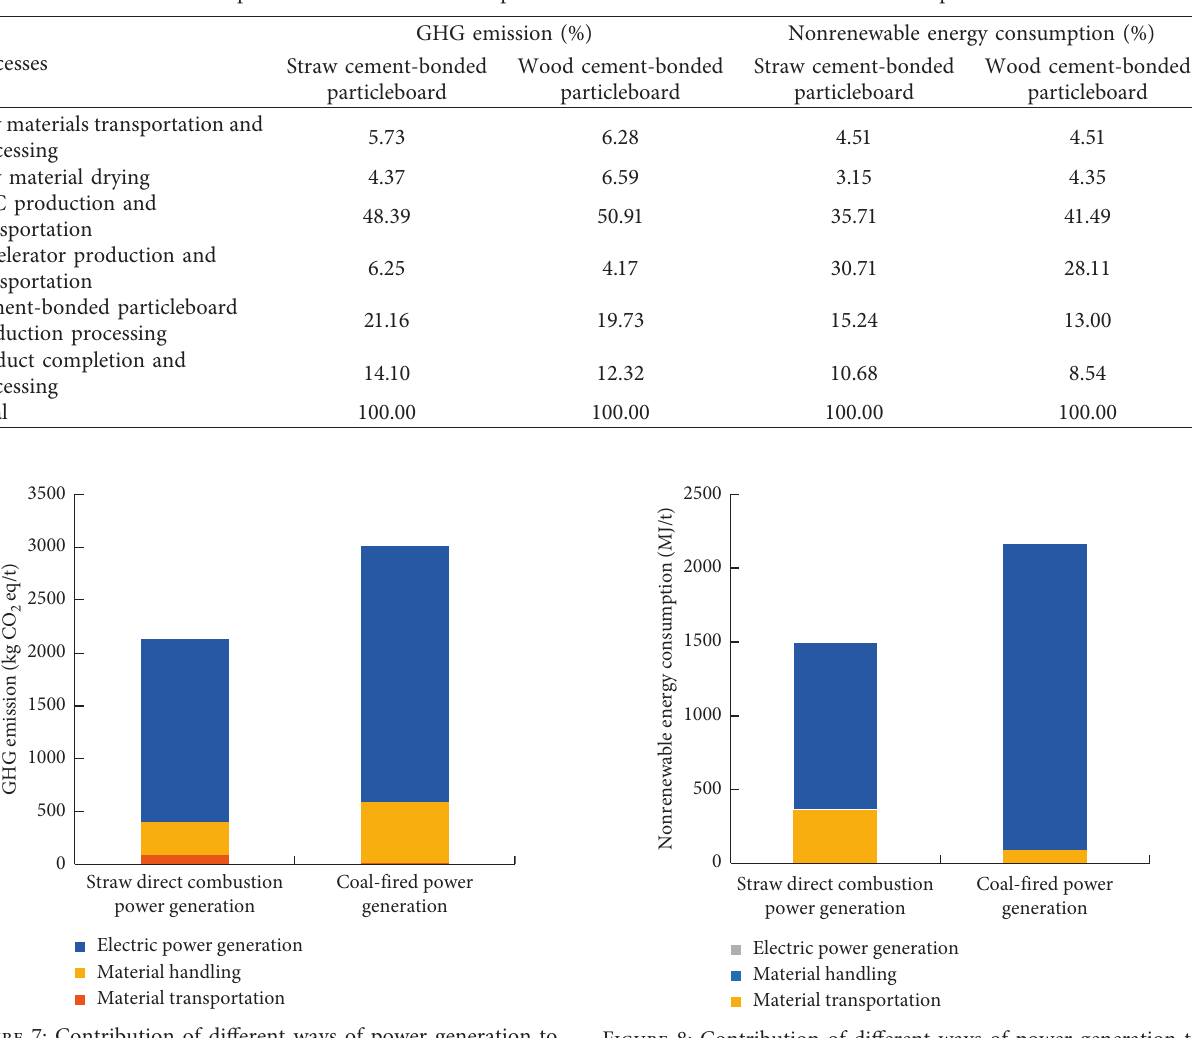
Figure 8: Contribution of different ways of power generation to nonrenewable energy